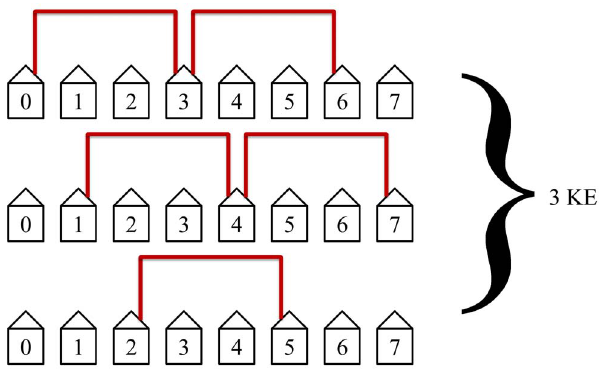
Figure 9. The third step in the protocol connects the third nearest neighbors. This step is not as efficient as the first two steps